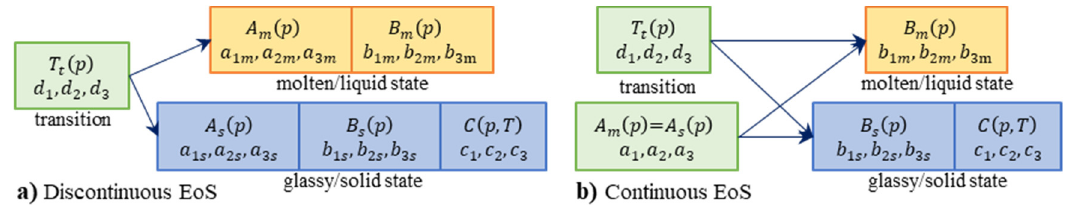
Figure 2. Parameter regression order of the discontinuous ( a ) and continuous ( b ) two-domain EoS.